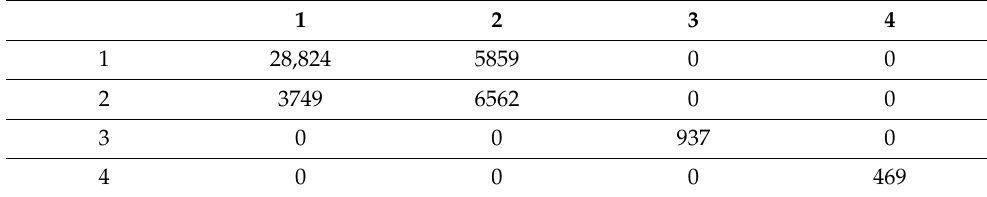
Table 7. The confusion matrix for